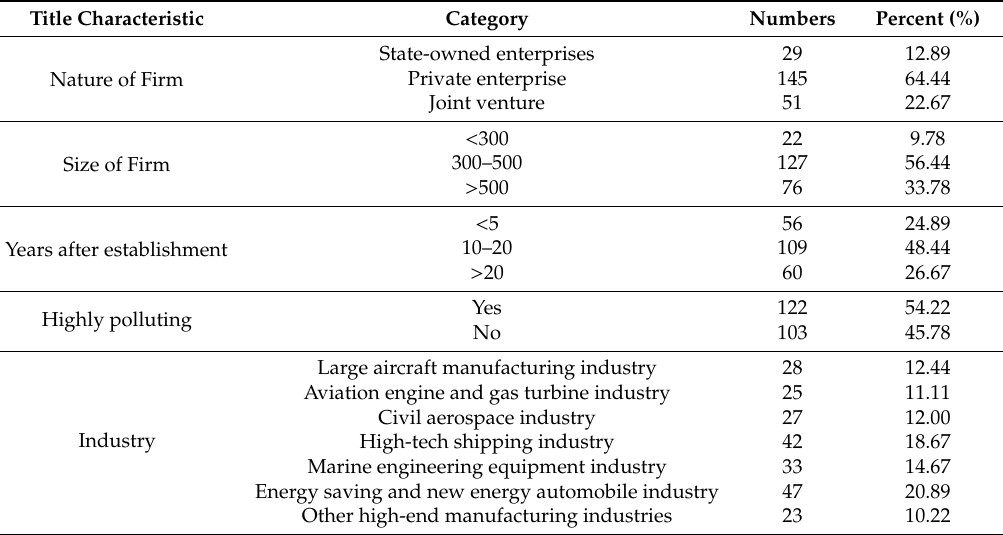
Table 1. Demographic characteristics of the